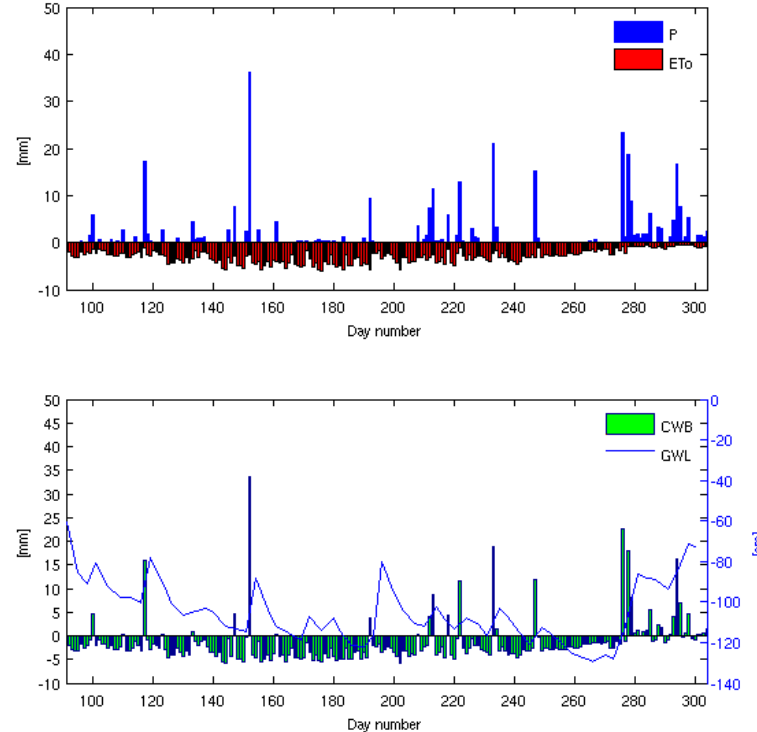
Figure 5. Variation of daily data of meteorological conditions during the vegetation season in the year 2016. P, precipitation; ETo, reference evapotranspiration; CWB, climatic water balance; GWL, ground water level.